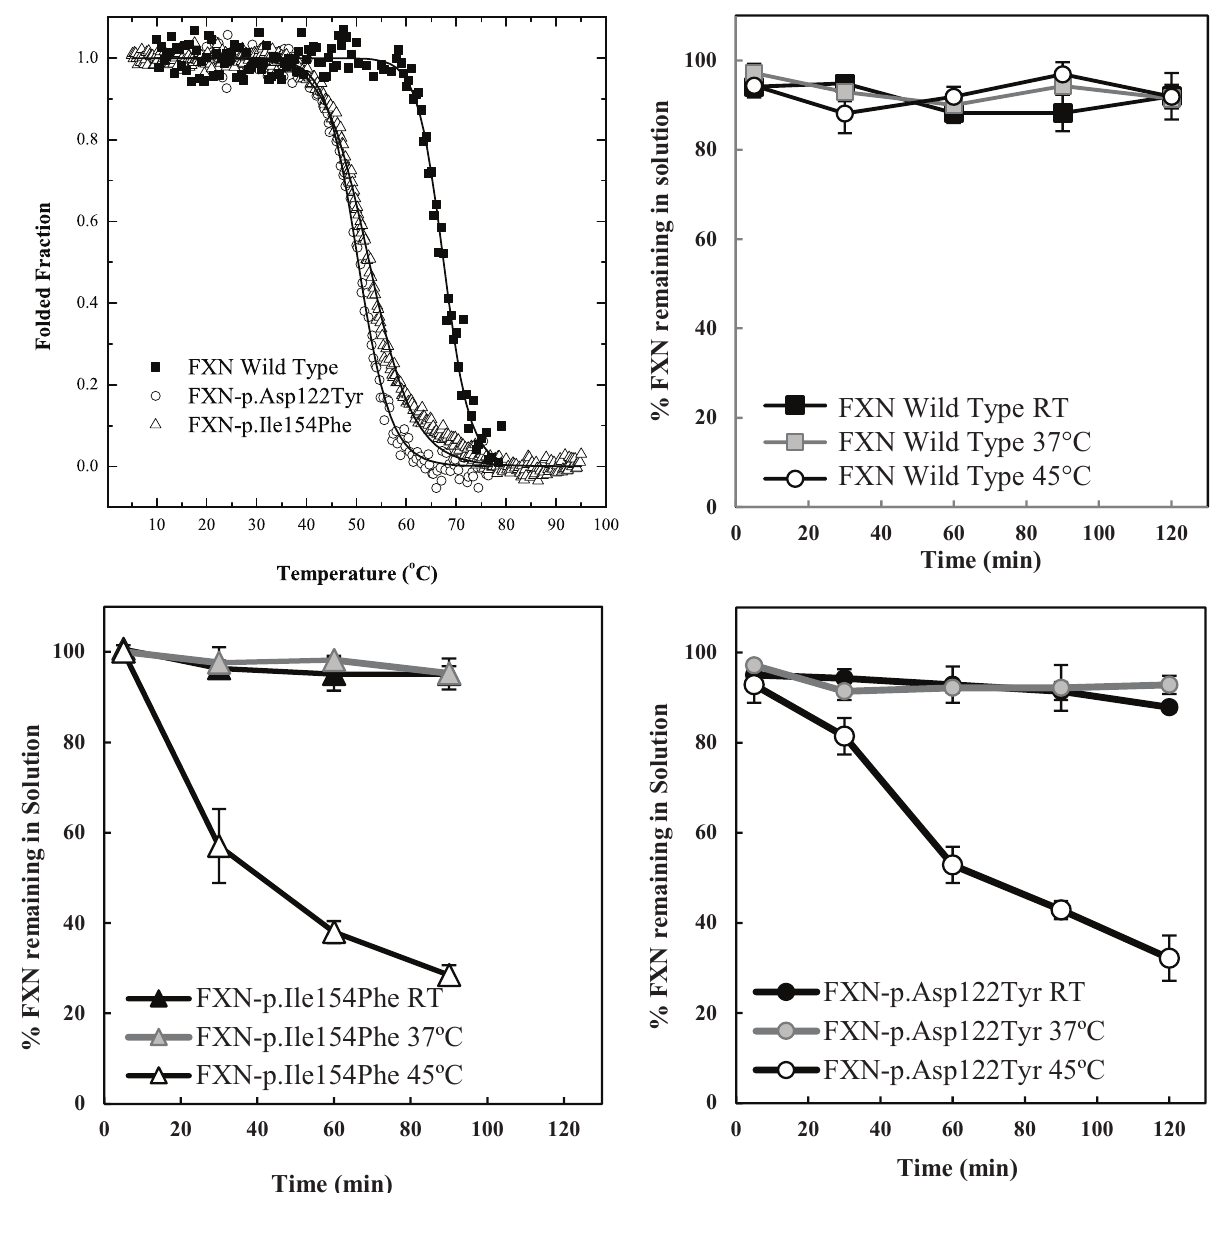
Wild type FXN, ( C ) FXN-p.Asp122Tyr (circles,) and ( D ) FXN-p.Ile154Phe (triangles)